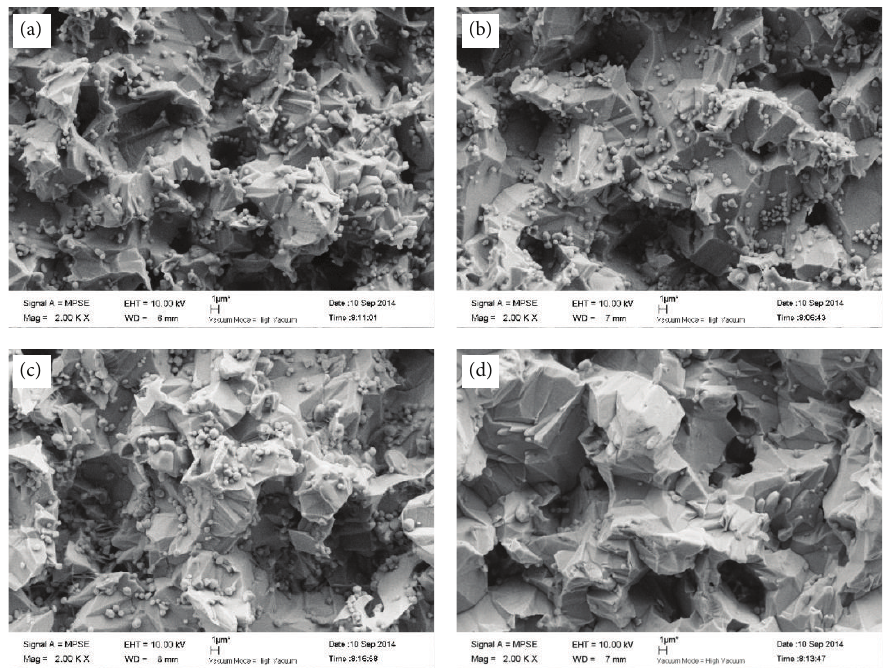
Figure 8: Fracture morphologies of AZO targets at different microwave starting temperatures: (a) 1000 ∘ C, (b) 1100 ∘ C, (c) 1200 ∘ C, and (d) 1300 ∘